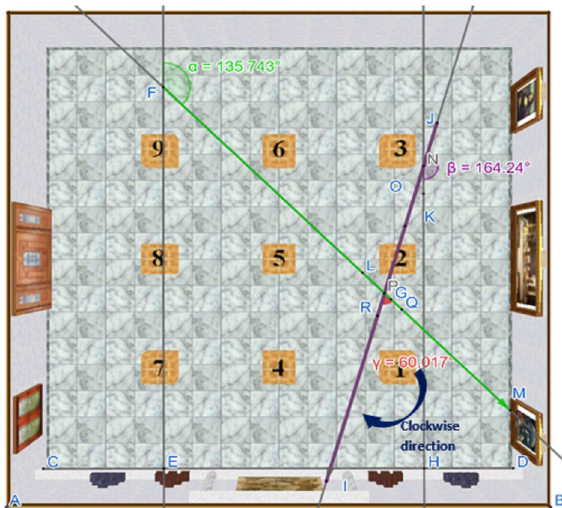
Figure 2. Final step of the angle and direction calculation for the ASMRT. Crossing the angles of the memory image and the recognition image in the zenith plane, we can obtain the difference between both angles (named α—green line—and β—purple line—, respectively) and the direction of the recognition image rotation, representing the exact viewpoint rotation between both images (angle and direction, represented in angle